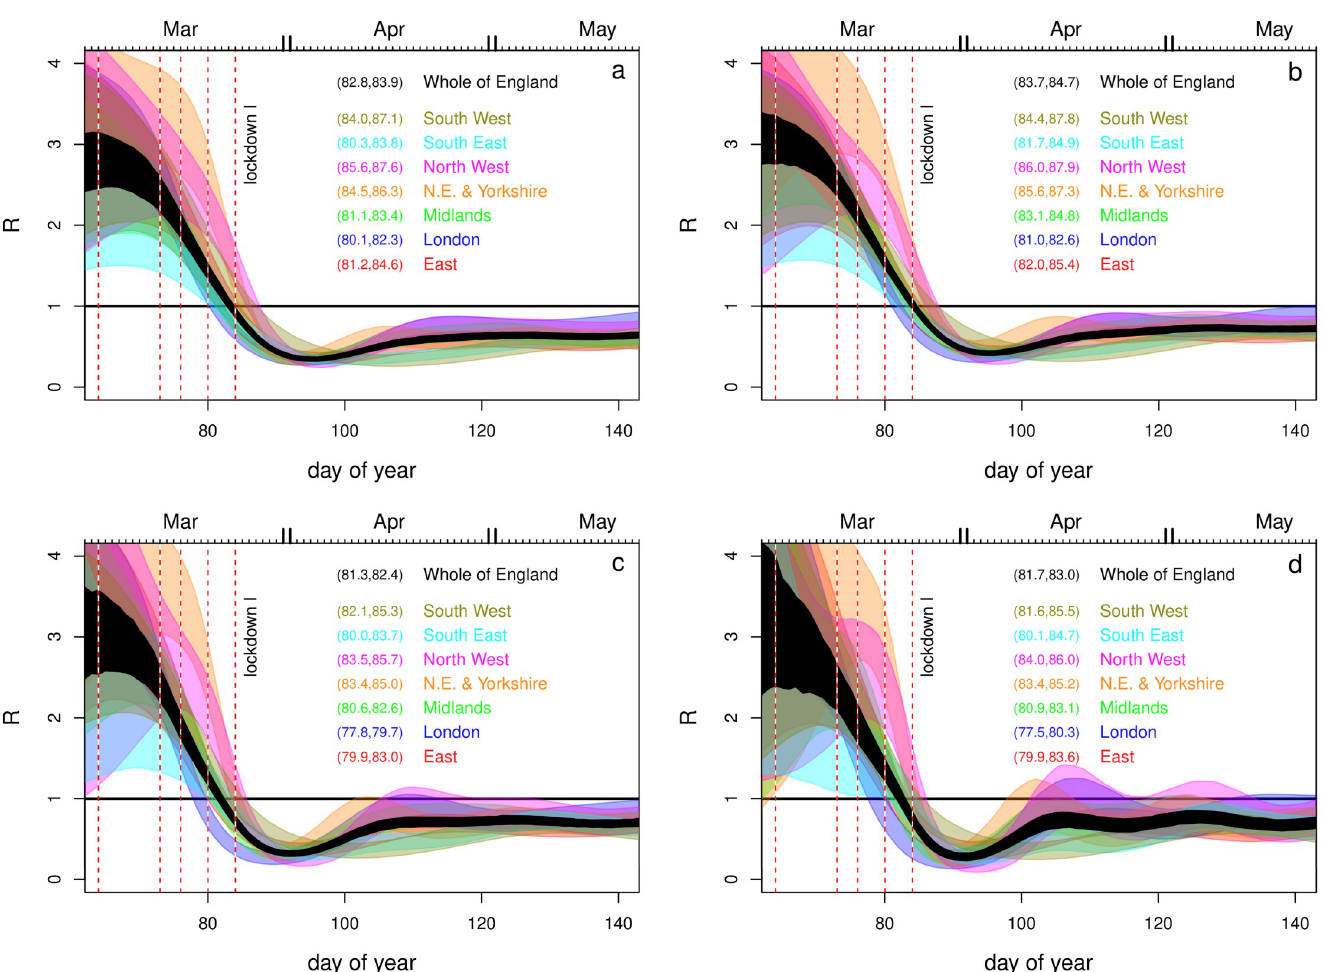
Fig 6. Comparison of inference around Lockdown I (March 24th 2020, day 84), for different modifications of the model of [1]. a . Piecewise linear b ( t ) replaced by adaptive spline. b . As a, but adjusting serial interval down towards literature range. c . The fully corrected model. As b, but with incubation period and time to hospitalisation set to values given in the papers cited by [1] for these quantities. d . As c, but with the smoothing parameters reduced by a factor of 4 from their estimated values as a sensitivity check. The numeric intervals given are nominal 95% CIs for the day on which R < 1 first occurred.